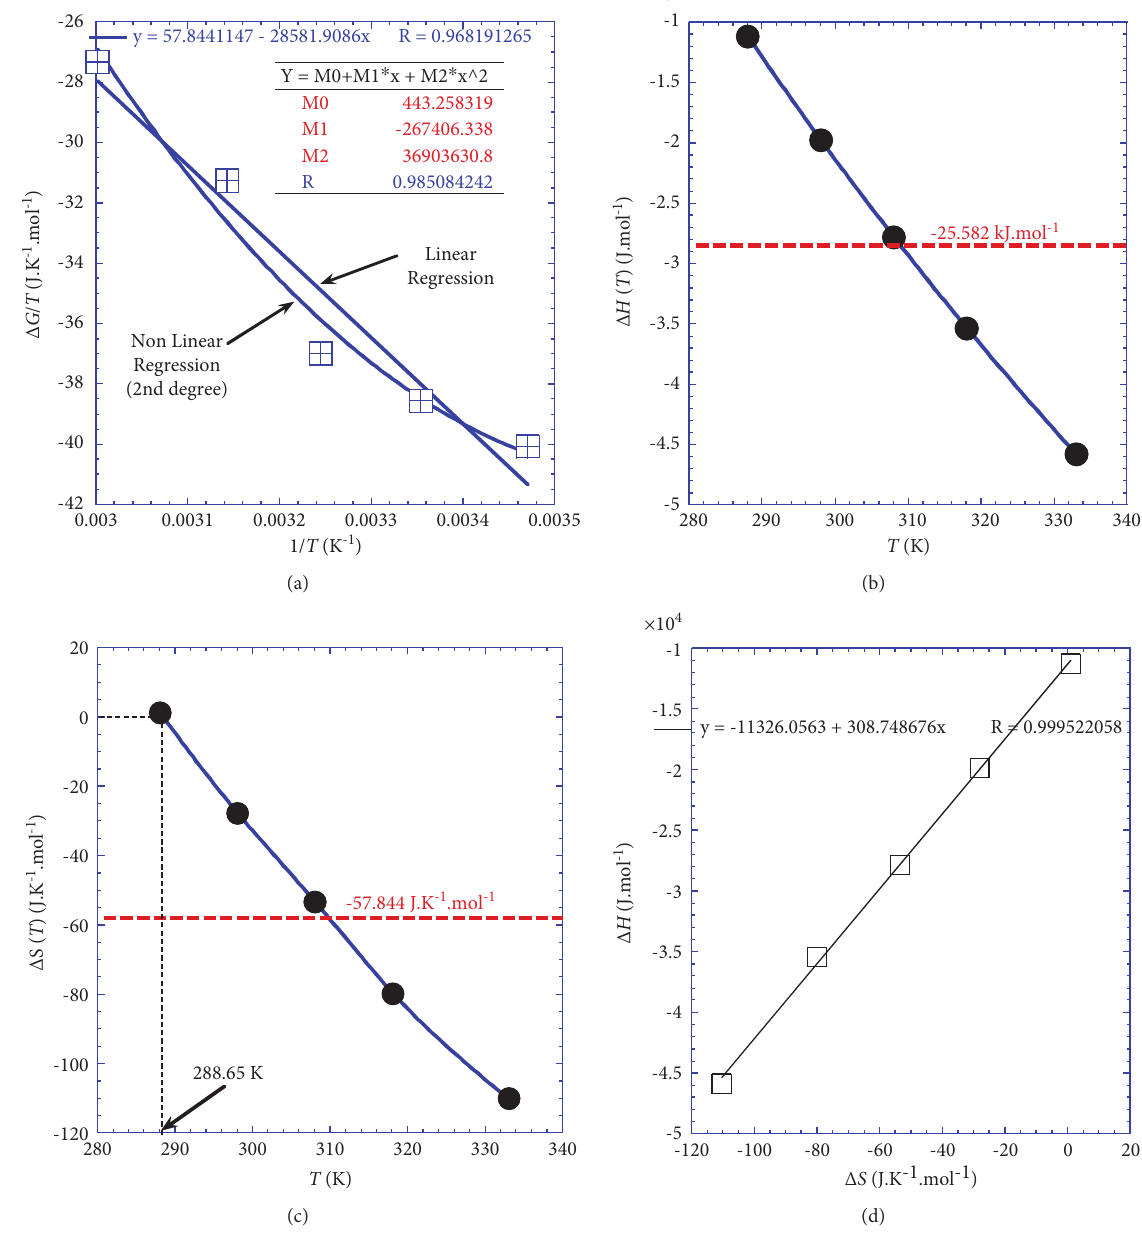
Figure 8: (a) Variation of Δ G / T as a function of the inverse of the reciprocal temperature. (b) Variation of Δ H ° with temperature obtained by linear regression. (c) Variation of Δ H ° with temperature obtained by nonlinear regression. (d) Correlation between the Δ H ° and Δ S ° for the